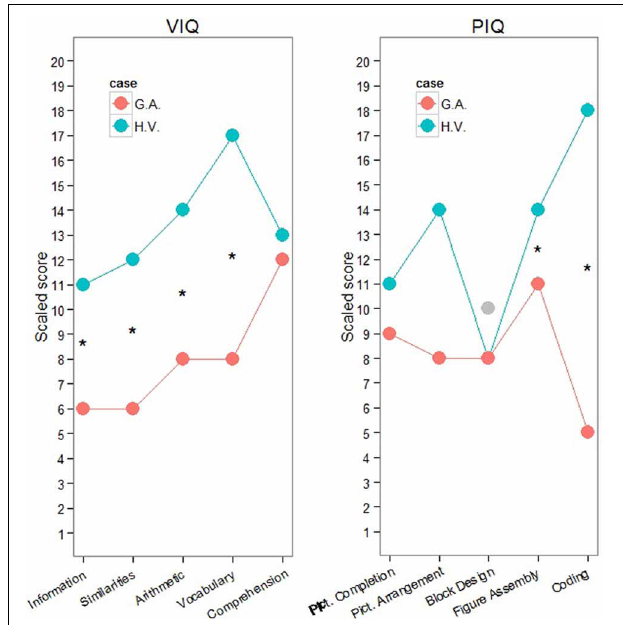
FIGURE 3 | H.V. and G. A. performances in intelligence, motor dexterity, visuospatial, short-term and working memory, executive functions, and phonological processing tasks. 9-HPT, Nine Hole Peg Test; ROCF, Rey-Osterrieth Complex Figure; ACT, Auditory consonantal trigrams; PRp, Pseudoword Repetition; PRd, Pseudoword Reading; PE, Phoneme Elision; VS, Victoria Stroop. Clinical score < − 1.5 SD